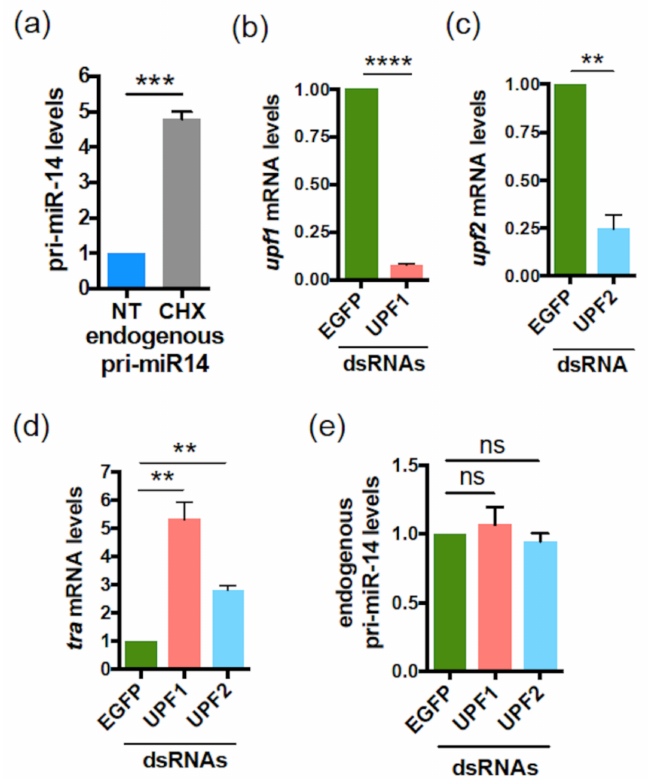
Figure 8. The Drosophila pri-miR-14 is regulated by CHX but not by NMD. ( a ) Relative expression levels of pri-miR-14 upon CHX treatment (30 µ g/mL for 4 h). Pri-miR-14 levels, determined by qRT-PCR, were normalized to RP49 and set to 1 for the untreated (NT) cells. Data are means ± S.E.M. n = 4. ( b – e ) Relative expression levels of Upf1 ( b ) or Upf2 ( c ) or tra mRNAs (used as positive control) (d) or pri-miR-14 ( e ) in S2 cells transfected with dsRNA directed against EGFP (used as control) of against Upf1 or Upf2 . The Upf1 , Upf2 , tra and pri-miR-14 levels, determined by qRT-PCR, were normalized to tubulin and set to 1 for EGFP dsRNA transfected cells. Data are means ± S.E.M. n = 4. ** p < 0.01, *** p < 0.001, **** p < 0.0001, ns: not